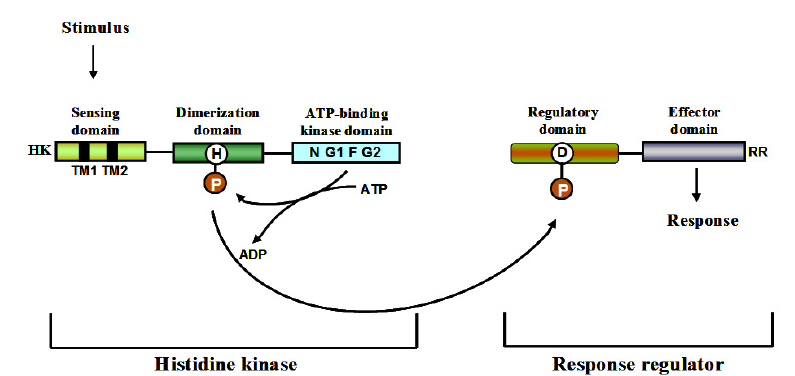
Fig. 1. Schematic representation of the conserved domains present in sensor kinases and response regulators 146